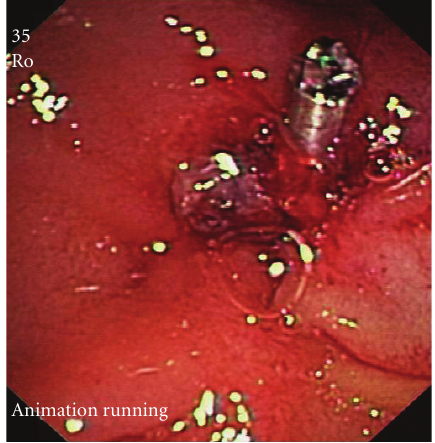
Figure 1: A clip was placed at the site of the sphincterotomy.